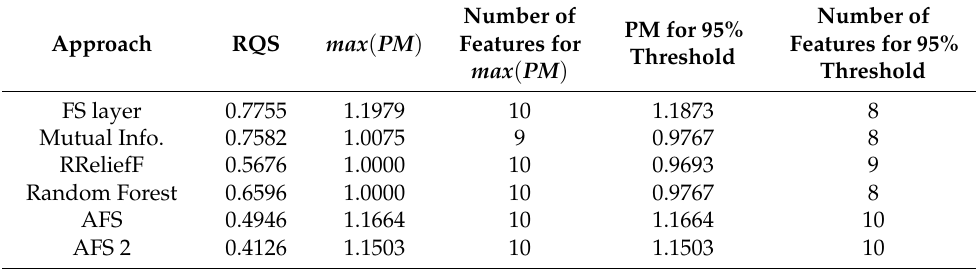
Table 16. Task performance and ranking quality for the NGTP case study.